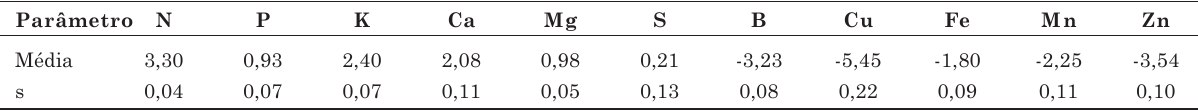
Quadro 2. Normas CND: média e desvio-padrão (s) para as relações multivariadas log centradas dos nutrientes para feijoeiro irrigado na região do Vale do Rio dos Bois,